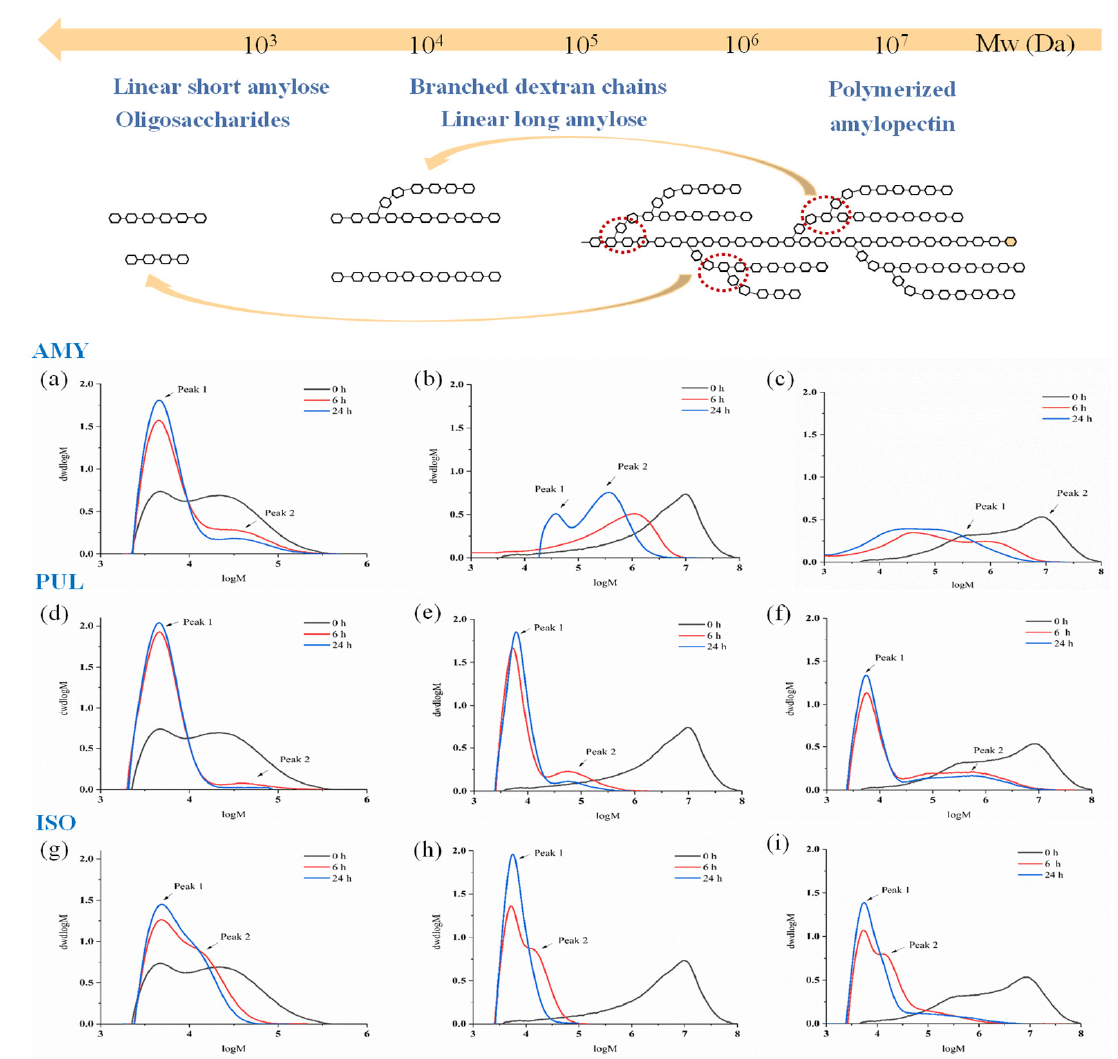
Figure 4. The molecular weight distribution of hydrolysates was obtained by debranching DE6 maltodextrin, waxy corn starch, and cassava starch using AMY, PUL, and ISO, respectively. The substrates of ( a , d , g ) were DE6 maltodextrin, ( b , e , h ) were waxy corn starch, ( c , f , i ) were cassava starch.